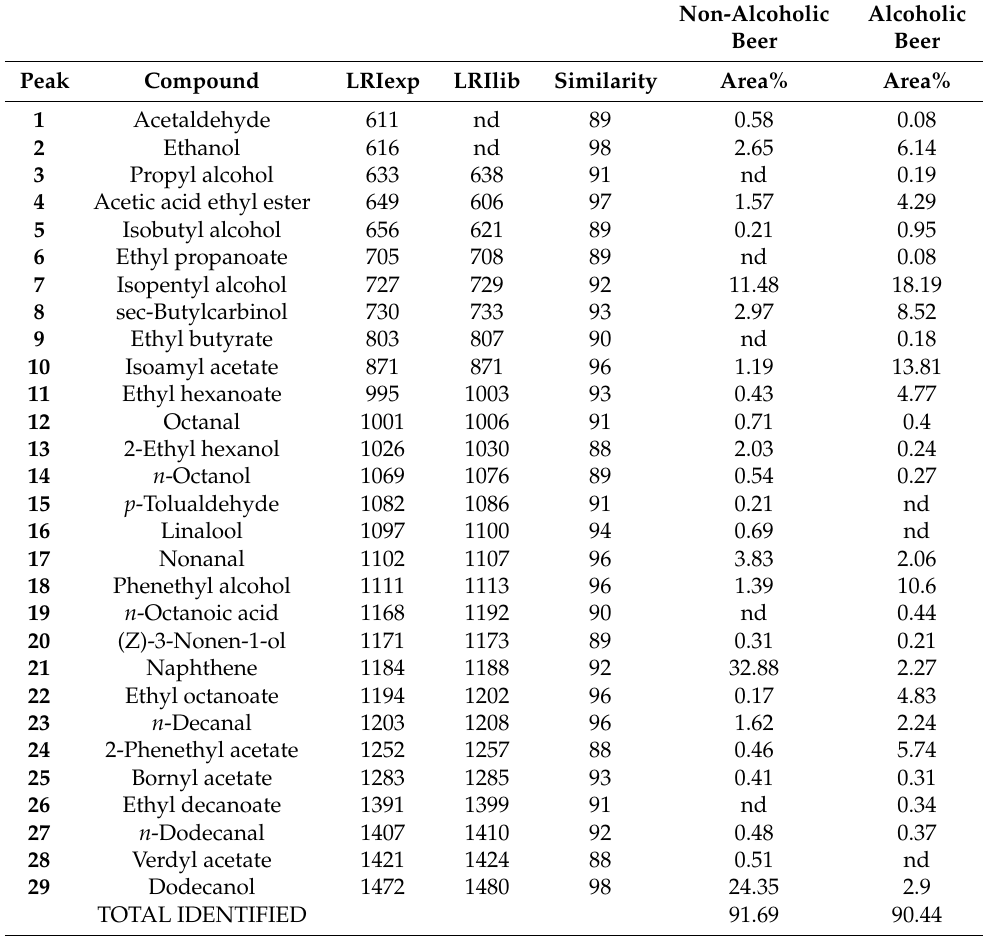
Table 1. List of compounds identified in alcoholic and non-alcoholic beer samples achieved by